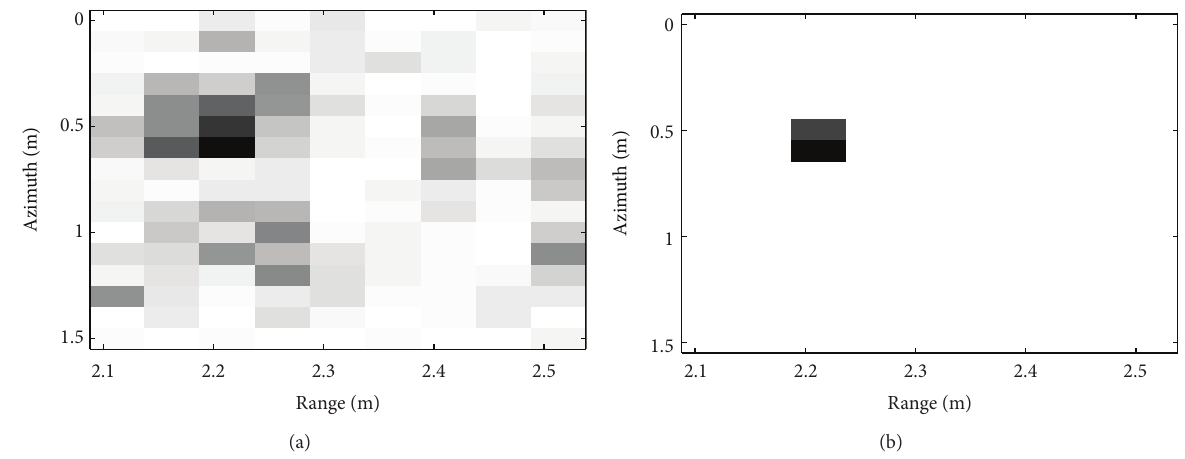
Figure 16: CS reconstructions of the behind-the-wall scene using a point-target dictionary. Downsampling factors were set to 40% for fast- time and 50% for azimuth. (a) 𝑙 1 -norm; (b)